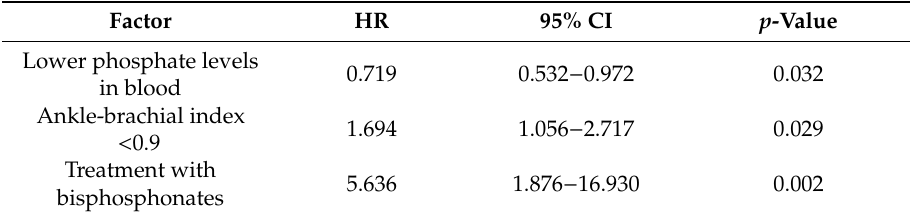
Table 3. Multivariate analysis for factors associated with the presence of vertebral fractures. Table 4. Death events and causes in patients with or without vertebral fracture.